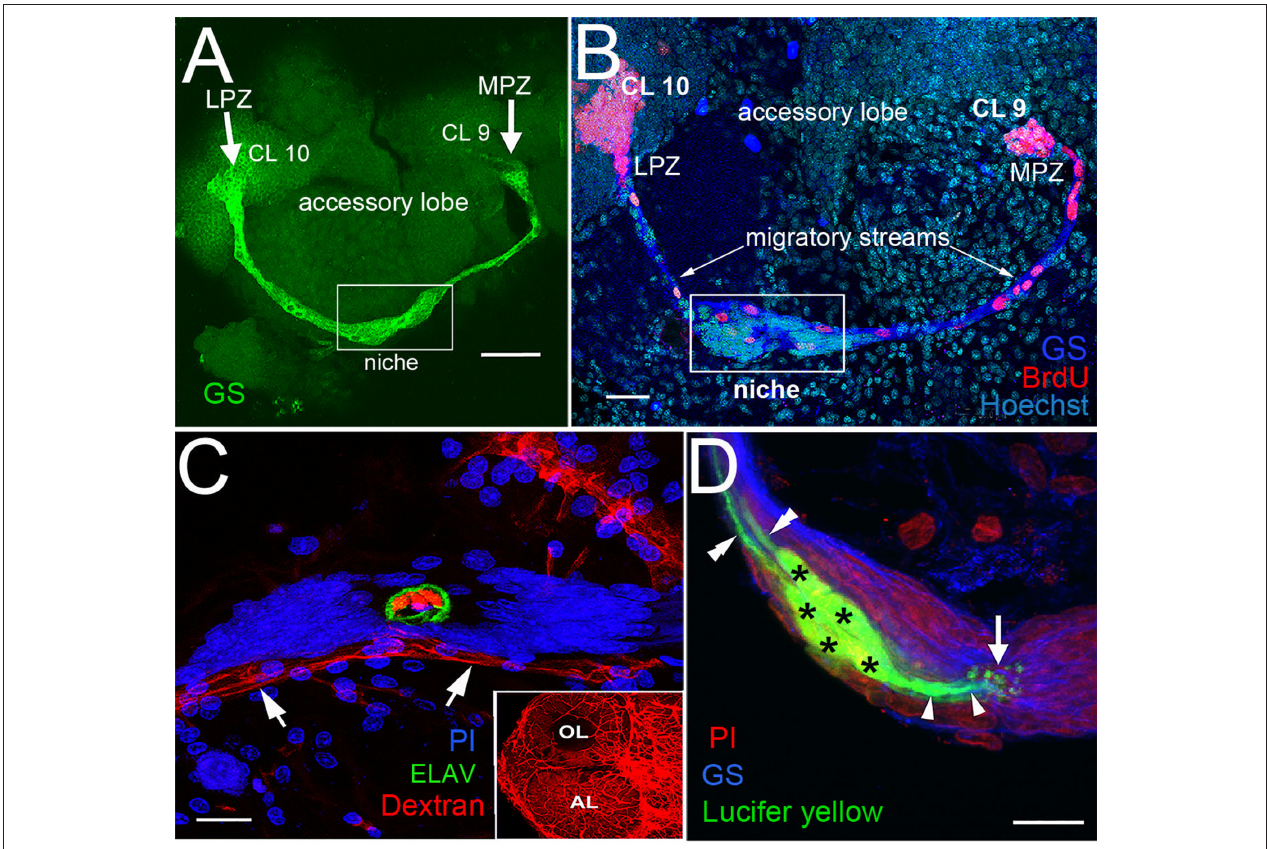
FIGURE 2 | The proliferative system maintaining adult neurogenesis in the crayfish ( Procambarus clarkii ) brain. (A) The lateral (LPZ) and medial (MPZ) proliferation zones are contacted by the processes of a population of cells immunoreactive to GS (green) whose somata are located in a neurogenic niche (white box) on the ventral surface of the brain. (B) Left side of the brain of P. clarkii labeled immunocytochemically for the S-phase marker BrdU (red). Labeled cells are found in the LPZ contiguous with Cluster 10 (CL 10) and in the MPZ near Cluster 9 (CL 9). The two zones are linked by a chain of labeled cells in a migratory stream that originates in the boxed region labeled “niche.” Labeling for glutamine synthetase (blue), BrdU (red), and Hoechst (cyan) is shown. (C) The vascular connection to the cavity in the center of the niche was demonstrated by injecting dextran tetramethylrhodamine dye into the cerebral artery. The cavity, outlined by its reactivity to an antibody to ELAV (green), contains the dextran dye (red), which is also contained within a larger blood vessel that lies beneath the niche (arrows). PI (blue) labeling of the niche cell nuclei is also shown. Inset: dextran-filled vasculature in the olfactory (OL) and accessory (AL) lobes on the left side of the brain. (D) Niche cells (green), labeled by intracellular injection of Lucifer yellow, have short processes (arrowheads) projecting to the vascular cavity (arrow) and longer fibers (double arrowheads) that fasciculate to form the tracts projecting to the LPZ and MPZ, along which the daughters of the niche cells (2nd-generation neural precursors) migrate. Glutamine synthetase (GS), blue; propidium iodide (PI), red. Scale bars: (A) , 100 µ m; (B) , 30 µ m; (C,D) , 20 µ m (A, C and D from Sullivan et al.,